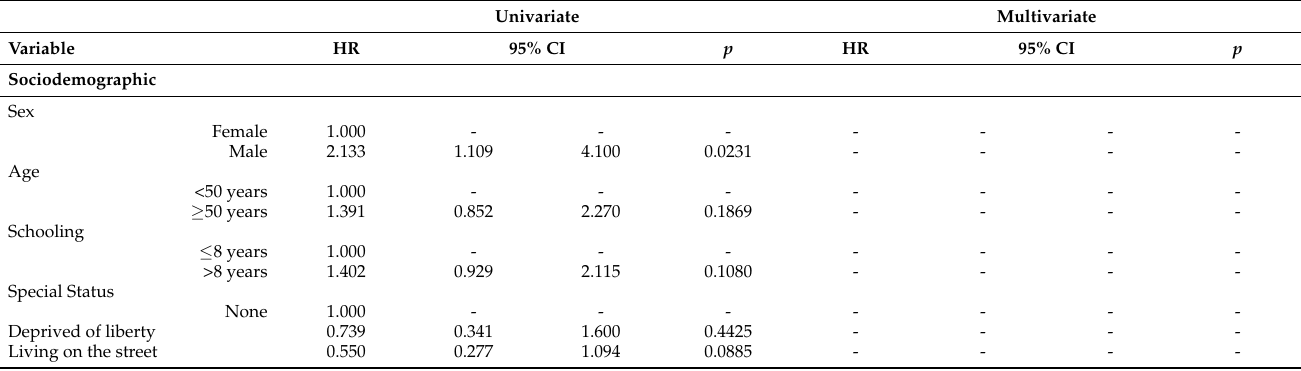
Table 2. Cox regression analysis for risk factors for curing tuberculosis ( n =